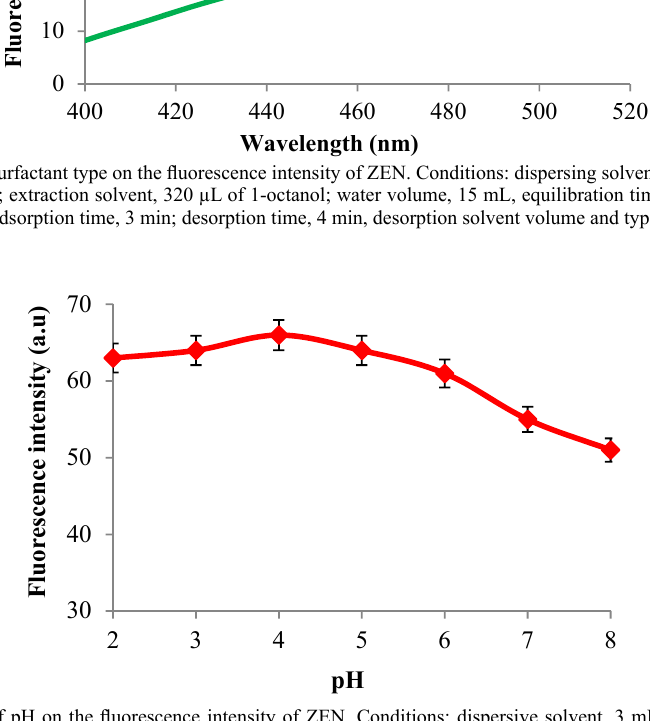
Fig. 5. Effect of pH on the fluorescence intensity of ZEN. Conditions: dispersive solvent, 3 mL of MeCN/water (80:20 v/v); extraction solvent, 320 µL of 1-octanol; water volume, 15 mL, equilibration time, 60 s, adsorbent amount, 40 mg; adsorption time, 3 min; desorption time, 4 min, desorption solvent volume and type, 1 mL of